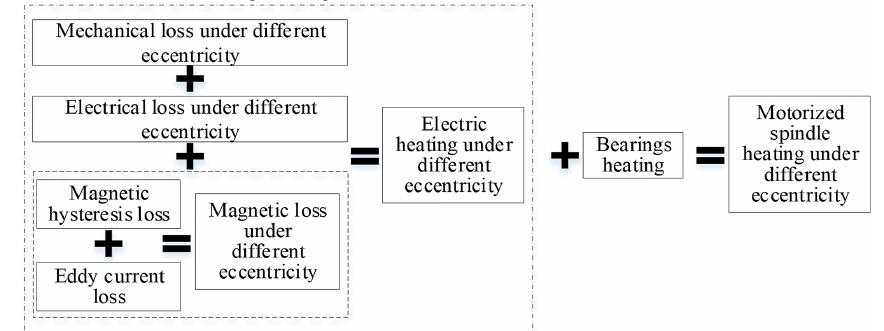
Figure 2. Motorized spindle heating model considering air-gap eccentricity.